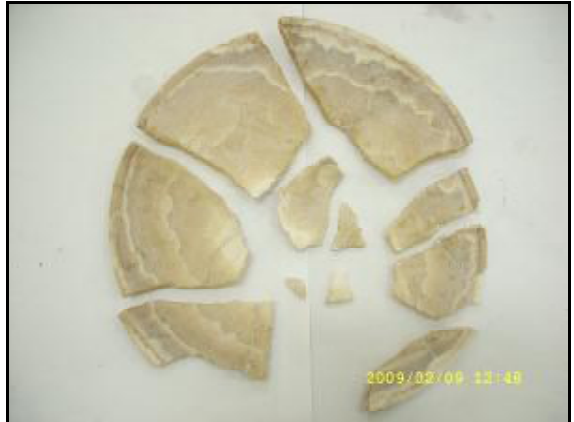
Figure 6 : The selected vessel after cleaning